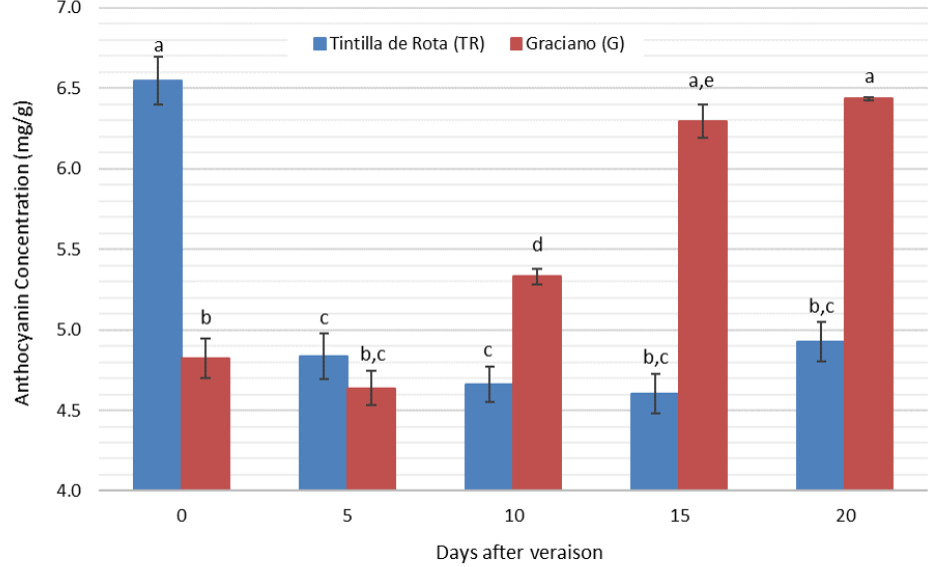
Figure 4. Evolution of total anthocyanin concentration quantified in ‘Tintilla de Rota’ and ‘Graciano’ accessions ( n = 3) in dry weight. Different letters mean there are significant differences between samples ( p < 0.05, two-way ANOVA, BSD test).